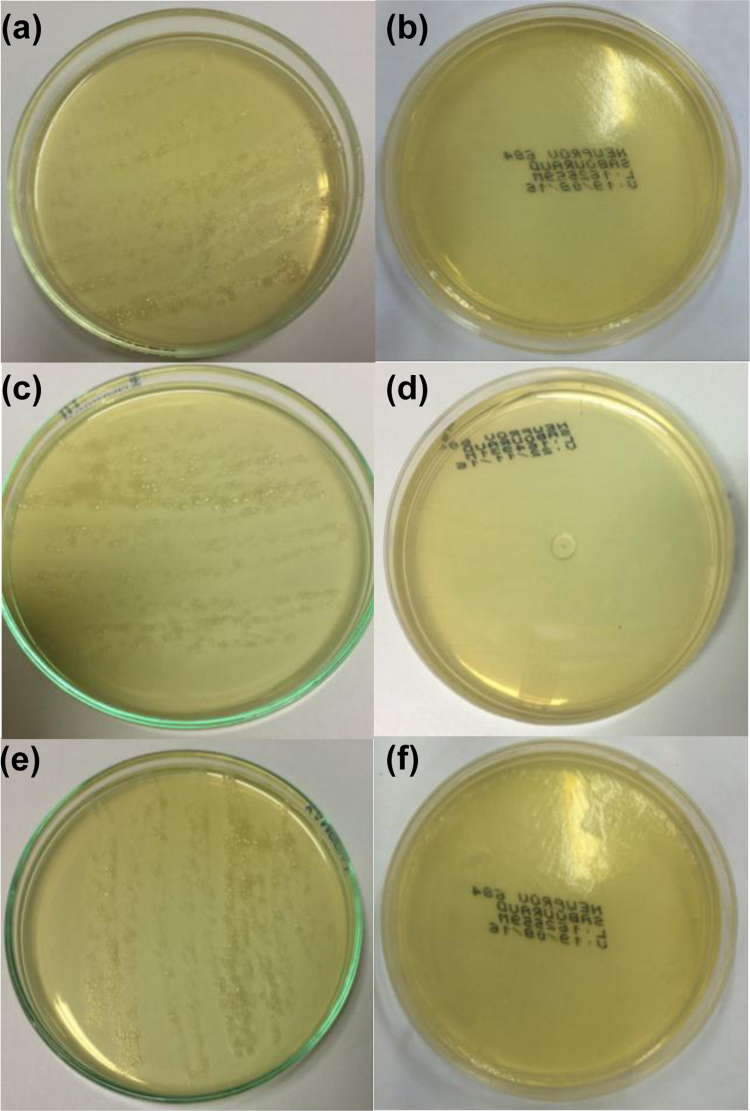
Inoculation of the non-sterile LNC 1 (a), LNC 2(c) and LNC 3 (e) and sterile formulations LNCS 1(b), LNCS 2 (d) and LNCS 3 (f) in a Sabouraud plate during 48 h at 35 ± 1 °C.